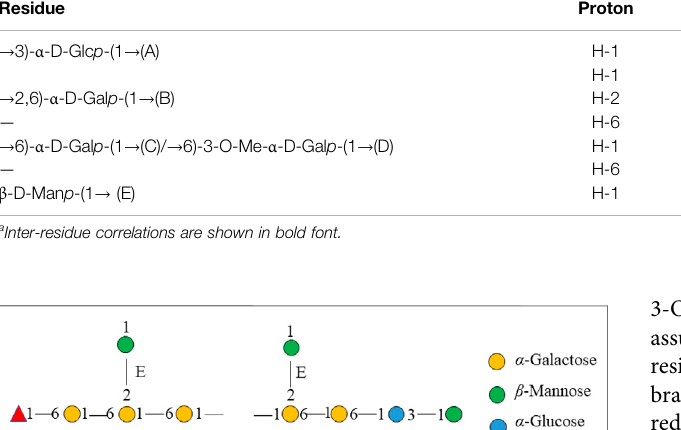
3-O-methyl-Gal p (NMR con fi rmed, see below). Therefore, we assumed that → 2,6)-D-Gal p -(1 → and → 6)-D-Gal p -(1 → residues formed the backbone of PPp-W, which was highly branched with D-Man p -(1 → as side chains linked via non- reducing termini. L-Fuc p -(1 → was positioned at the end of the sugar chain. 1 D/ 2 D NMR Analysis The structural feature of PPp-W was characterized using 1 D and 2 D NMR spectrum. The signals of anomeric protons (4.5 – 5.4 ppm) ( Figure 5A ) and anomeric carbons (90 – 110 ppm) ( Figure 5B ) suggested PPp-W contained α - and β -con fi gurations, which was consistent with the results of FT-IR. Six signals occurred at δ 5.38, 5.15, 5.01, 4.94, 4.80, and 4.51 in 1 H NMR; the signal at δ 4.80 overlaped with the peak of D 2 O in 1 H-NMR. Due to the overlap, only three anomeric carbon signals were visible at δ 104.54, 102.47, and 100.98 in 13 C-NMR spectrum ( Figure 5B ), which were resolved in the HSQC spectrum ( Figure 5D ). The anomeric regions showed C1/H1 signals at δ